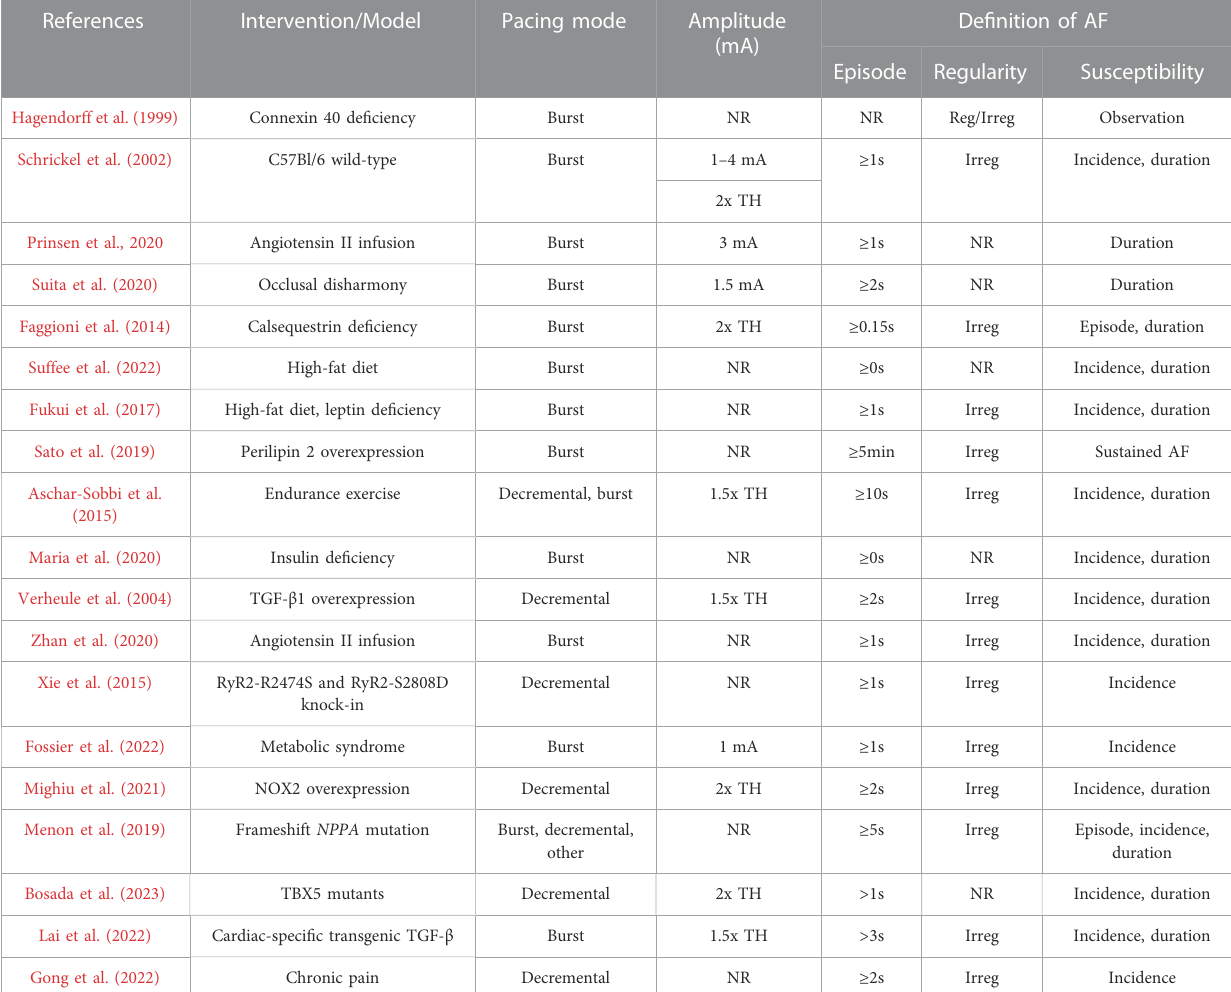
TABLE 2 Selected studies using transesophageal PES to induce